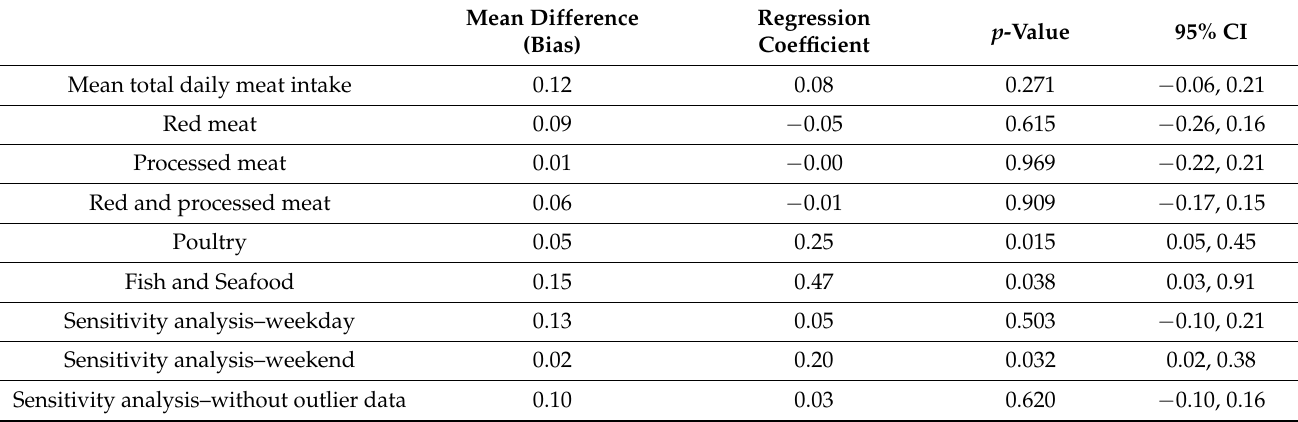
Table 4. Linear regression analyses for magnitude bias for quantifying meat intake in Weeks 1 and 3 of the MFQ.